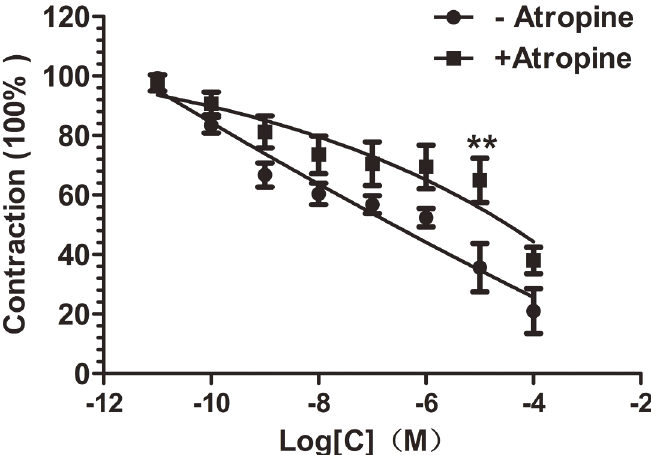
Fig 5. Role of Atropine (1 × 10 – 6 mol (cid:1) L -1 ) in the vasodilation induced by compound 1. Use the endothelium-denuded aortic rings. Data are showed as mean ± S.E.M., n = 6, * P <